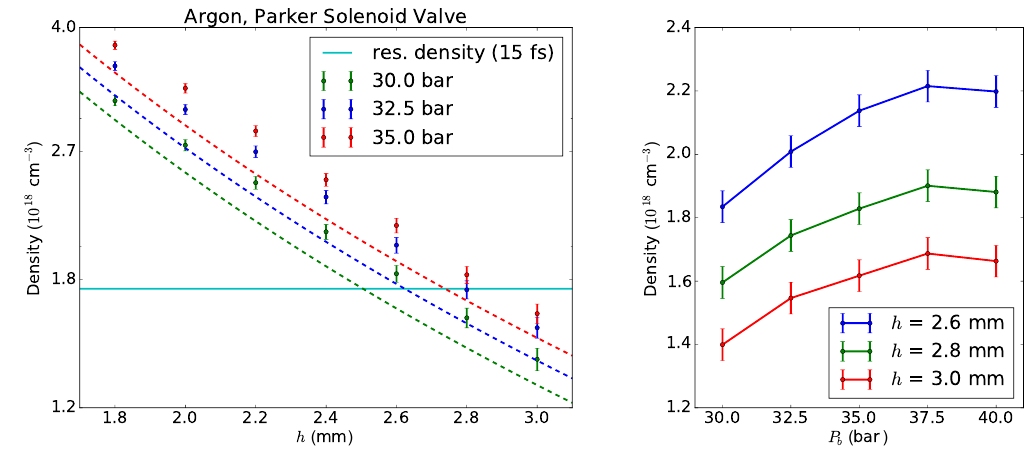
Figure 15. ML-EM reconstructed on-axis density of the solenoid valve without blade. ( Left ) Dashed lines represent the estimate for the respective backing pressure. The data points with error bars are from the measurements. The resonant density is reached with backing pressures between 30 and 35 bar in the region of interaction for the Ti:Sa pulse ( h = 2.6–2.8 mm). ( Right ) The density appears to increase for pressures up to 37.5 bar. For higher pressures, stagnation and even regression are